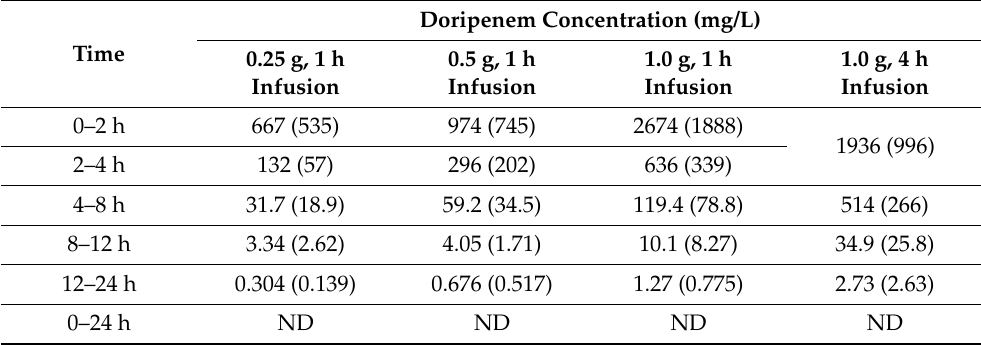
Table 3. Mean segmented doripenem concentration in urine of healthy Chinese subjects after a single intravenous infusion of doripenem (n = 12).